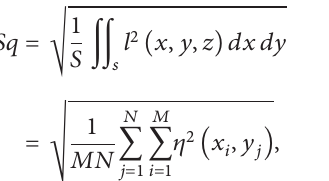
Figure 10: CCMT120404-HM YBM251 type cutting tool